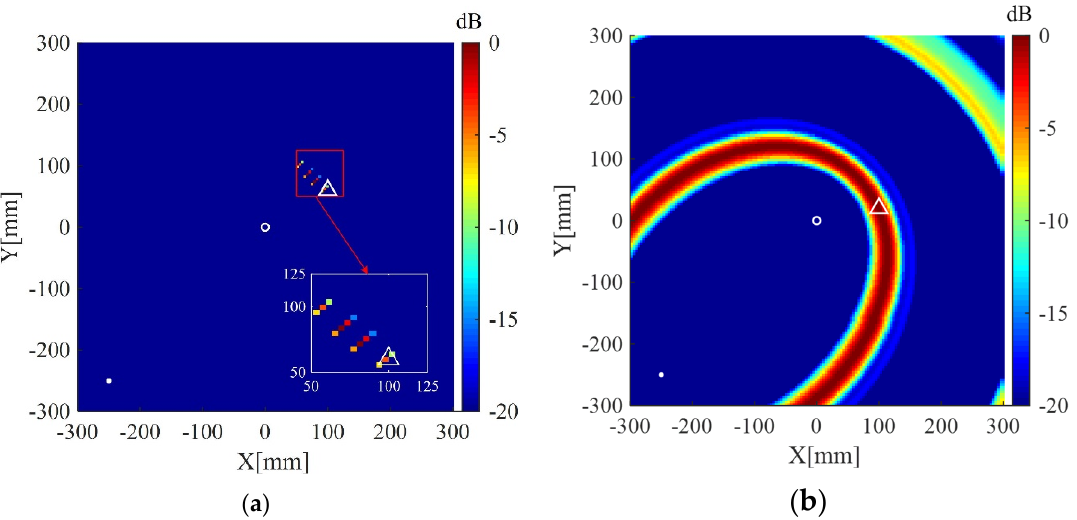
Figure 12. ( a ) Imaging result of the weighted structured sparse reconstruction ‐ based Lamb wave imaging method using data from one receiver (the location error is 20 mm); ( b ) Imaging result of the delay ‐ and ‐ sum imaging method using data from one receiver (the scatter cannot be located). White dots denote locations of PZT receivers, the white circle denotes the location of the excitation source, and the white triangle denotes the location of the scatterer.